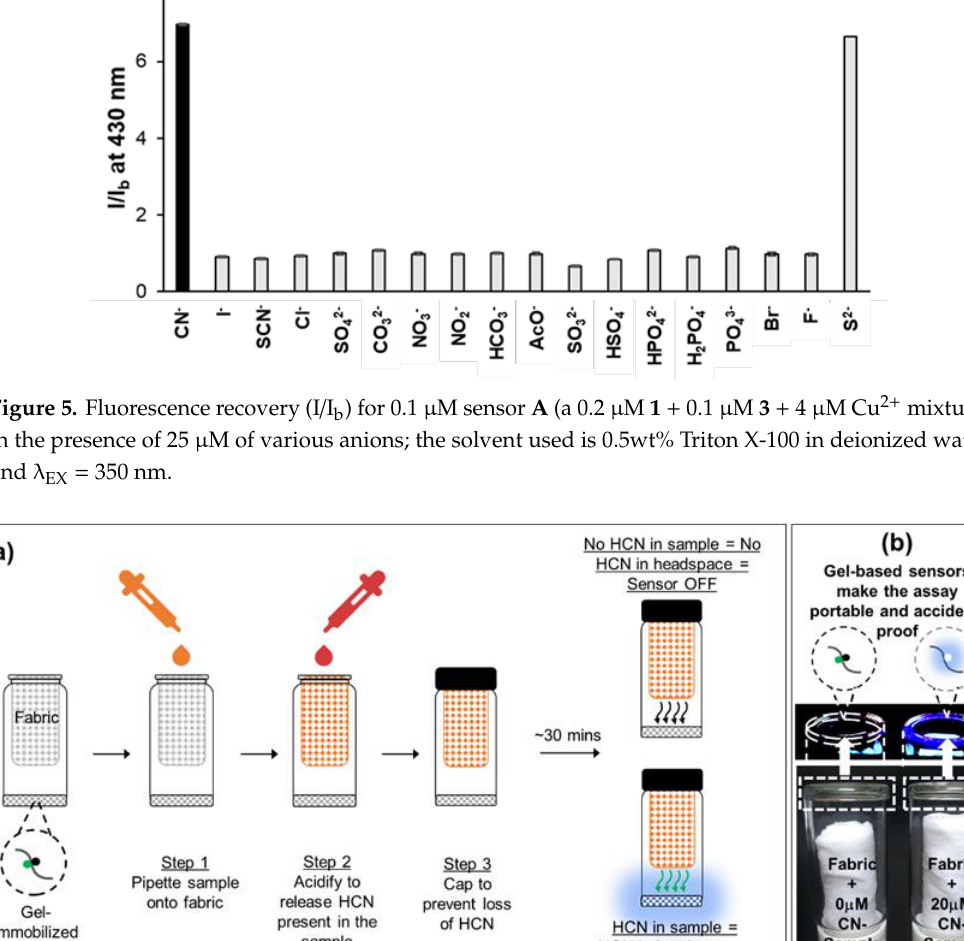
Figure 7. (a) Photographs, taken under UV illumination, show that the sensor, located at the bottom of the assay vial, while never in contact with the sample, produces a visually discernible response for samples contain ing ≥ 20  M cyanide. (b) Photographs, taken under UV illumination, using BSA solutions. (c-h) Photographs, taken under UV illumination, show that inclusion of bismuth nitrate in the acidification reagent overcomes sulfide interference and does not produce false positives with other common volatile species expected in biological samples. The acidification reagent comprises 1g/L Bi(NO 3 ) 3 .5H 2 O in 0.55M H 2 SO 4 . All pictures are taken 30 min after acidification under UV illumination (  EX = 350nm). The gel-immobilized sensor used comprises 0.5% agar, 0.26  M fluorophore, 0.75  M polymer and 2  M Cu 2 in DI water. 3.4. Cyanide Sensing Hydrogels Figure 8a compares the cyanide-induced fluorescence recovery of sensor A in solution (open circles) with that of sensor A within an agarose hydrogel (open squares) and shows that gel immobilization increases sensor A ’s cyanide sensitivity. As discussed earlier (Figure 3a), the cyanide sensitivity of 1+3+Cu 2+ complexes like sensor A can be improved by lowering relative Cu 2+ levels within the complex. Since D-galactose, a component of the agarobiose repeat unit that makes up agarose, is known to coordinate with Cu(II),[53-57] we hypothesize that agarose displaces a fraction